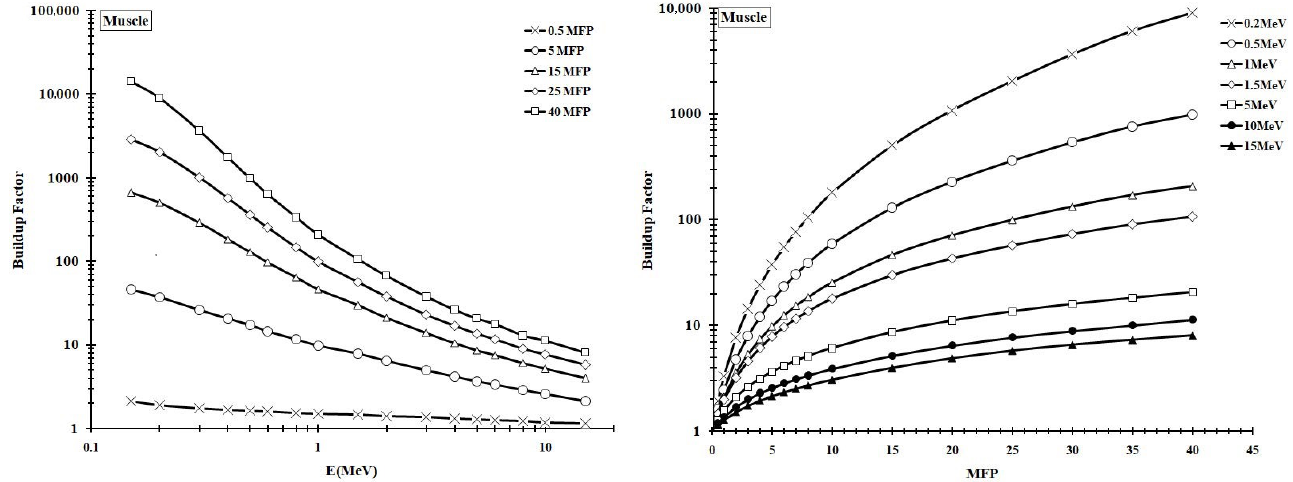
Figure 12. Buildup factor for muscle tissue as a function of: ( left side ) photon energy for fixed depths between 0.5 and 40 mfp and ( right side ) depth for fixed photon energies between 0.15 and 15 MeV.